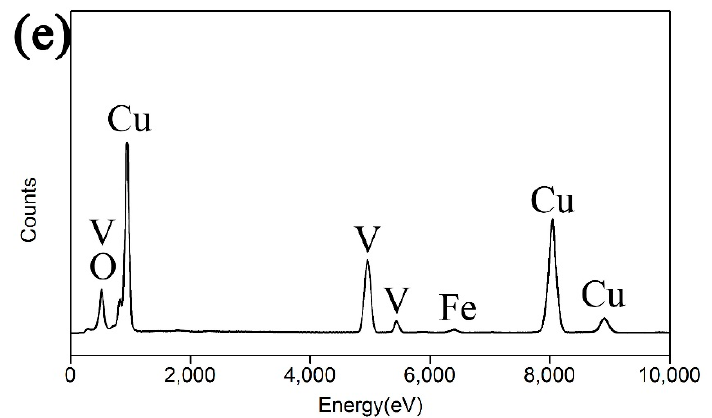
Figure 5. ( a ) TEM image of composite sintered at 900 °C; ( b ) SAED pattern of copper matrix in ( a ); ( c ) BF image showing the nanosized V particles below 10 nm; ( d ) HRTEM image of the interface between V and Cu and ( e ) the EDS result of the V particle in ( c ).